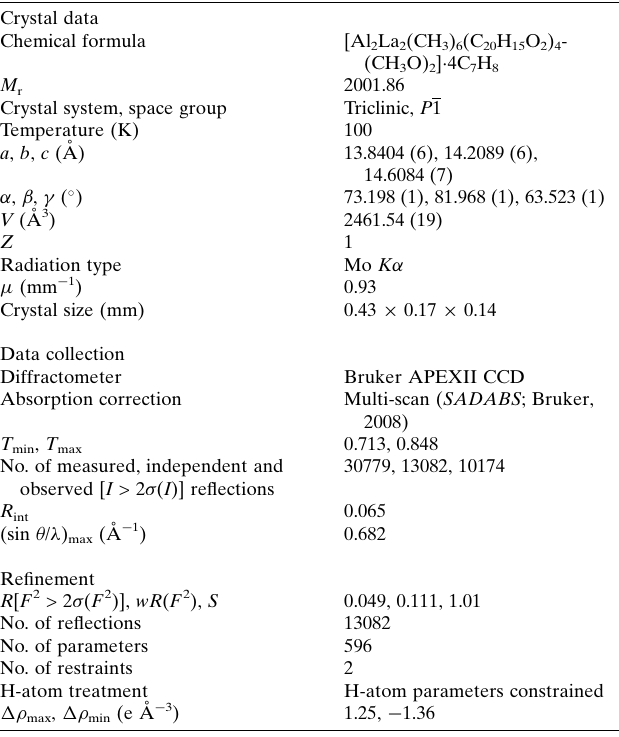
Table 3 Experimental details. Crystal data Chemical